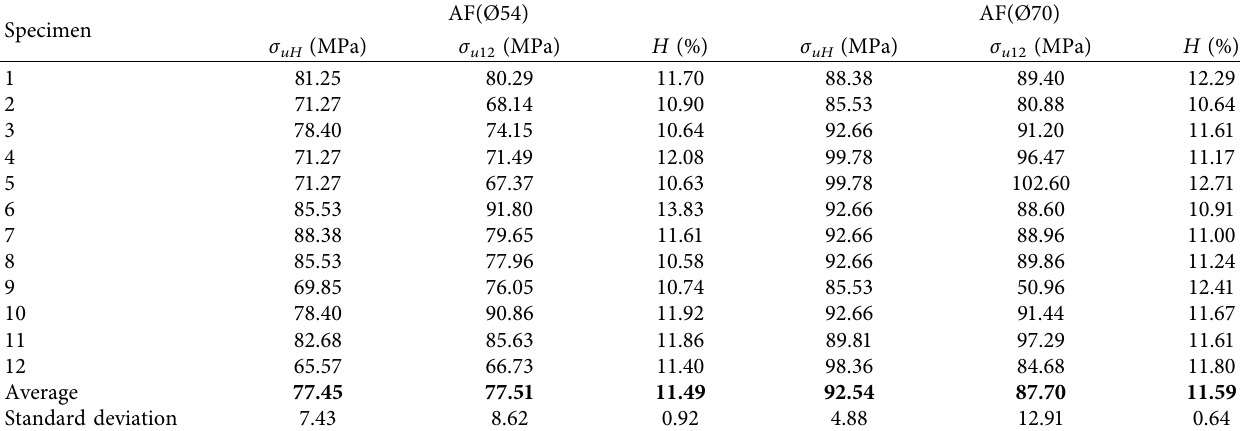
Table 1: Failure stresses in 4-point bending, diameters 54cm and 70cm.